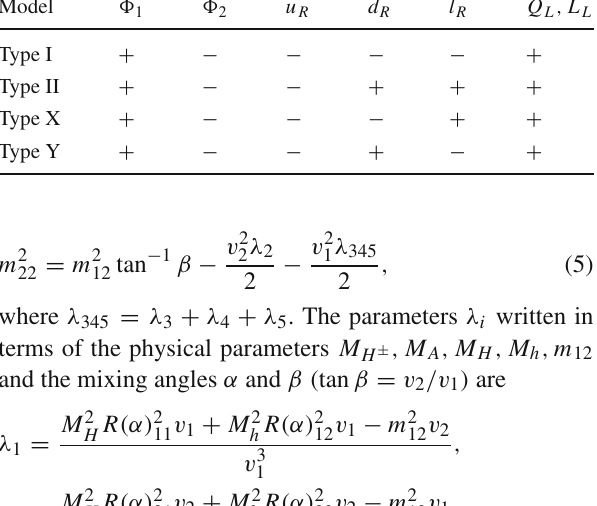
Table 1 Charge assignment under Z 2 symmetry to avoid FCNC at tree level